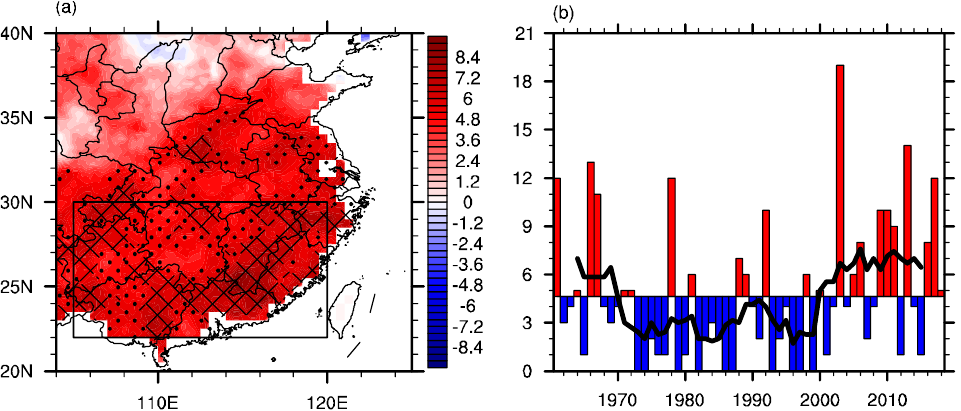
Figure 2. ( a ) The differences of summer FEHE between P2 and P1 (P2 minus P1, unit: 1). ( b ) The time series of summer regional FEHE over southern China (bar) and of 7–year running mean in regional FEHE over southern China during summer (line) (unit: 1). Dots and meshes in ( a ) denote where the anomalies are significant at the 90% and 95% confidence levels based on Student's t test, respectively. The black rectangle in ( a ) refers to the domain of southern China.